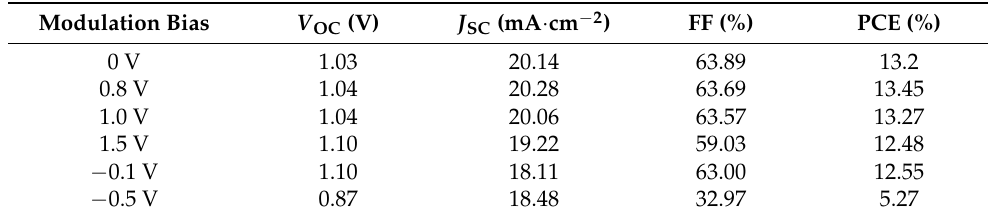
Figure 1. ( a ) J–V curve of quasi-2D perovskite [(BA) 2 MA 3 Pb 4 I 13 , n = 4] solar cells processing with preheating of 90 ◦ C and 100 ◦ C under forward and reversed scan. ( b ) PL spectra of perovskite films from front sides at 90 ◦ C and 100 ◦ C preheating temperatures. Table 1. Photovoltaic parameters of electric field modulated quasi-2D perovskite solar cells under different modulation bias at 200 s with the same batch of devices.